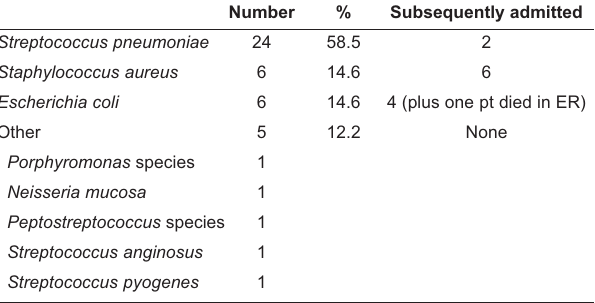
TABLE 6 Microorganisms isolated from blood of ambulatory patients with community-acquired pneumonia and the number of these patients who subsequently required admission for treatment of